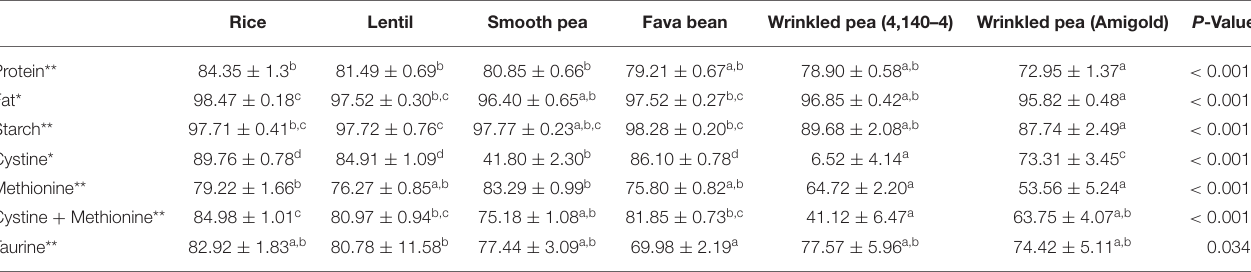
TABLE 4 | Total tract apparent digestibility analyses of protein, fat, starch, cystine, methionine, cystine + methionine and taurine in the 6 different test diets formulated at 20% available carbohydrate with variable amounts of fiber, fed for 7 days. Rice Lentil Smooth pea Fava bean Wrinkled pea (4,140–4) Wrinkled pea (Amigold) P -Value